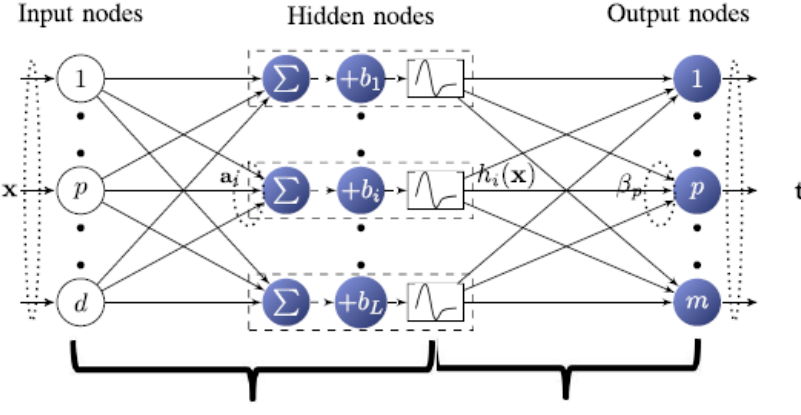
Figure 3. Schematic neuron network structure [42].